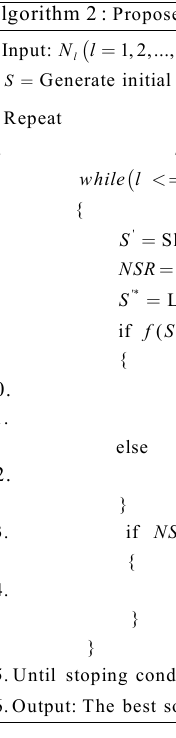
Fig. 7. Pseudo-code of the proposed VNS